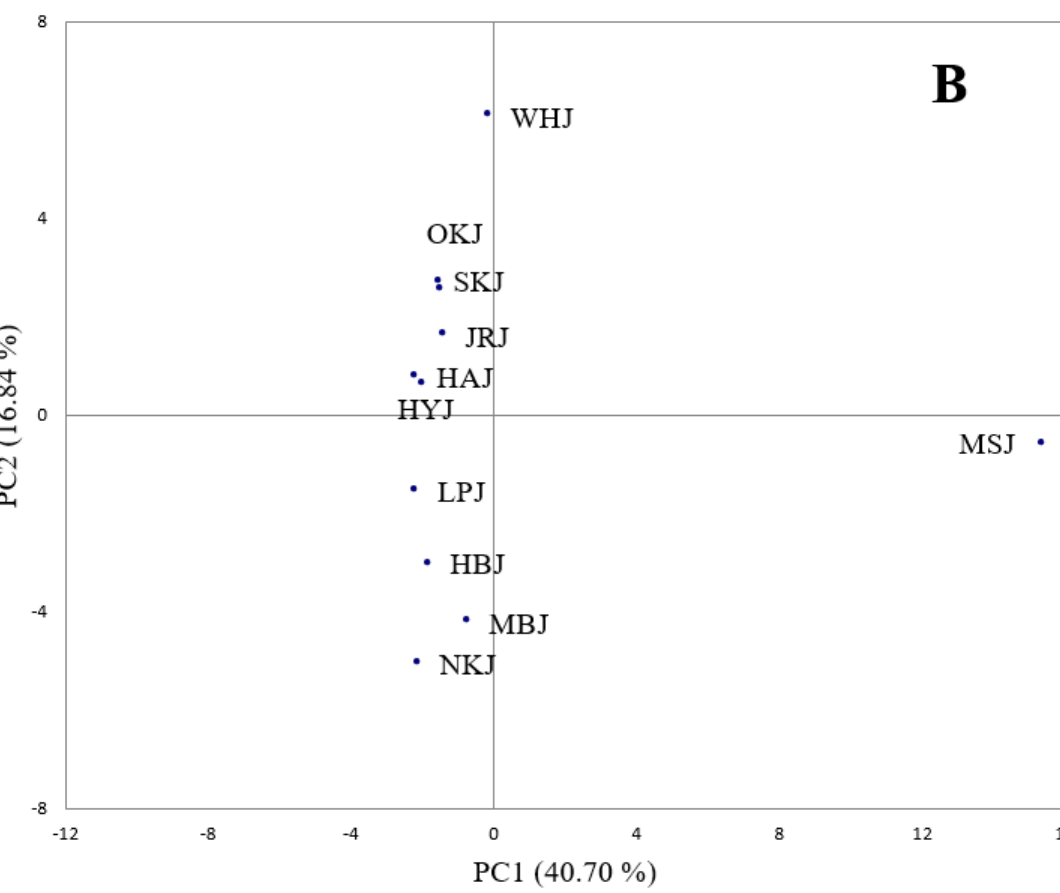
Figure 1. Principal component analysis loadings for 59 volatile compounds ( A ) and scores for the 11 distilled soju samples ( B ). The sample and volatile compound codes are defined in Tables